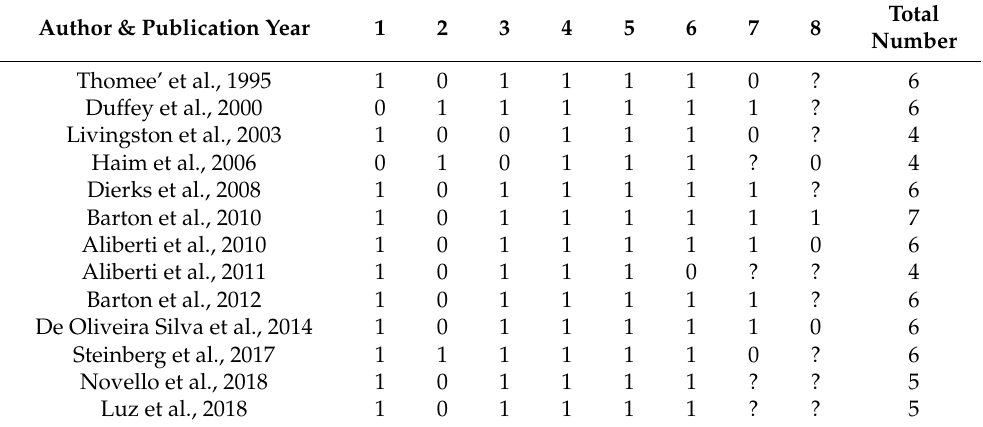
Table 1. Quality